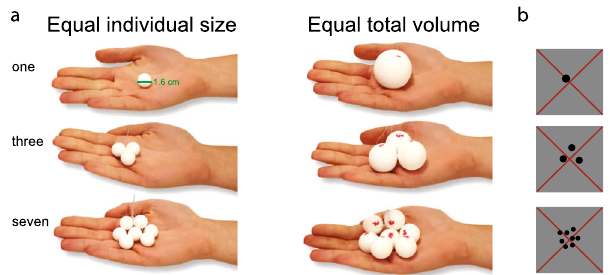
Fig. 1 Illustration of the stimuli. a Static images show the two different haptic stimulus conditions, with examples of different numerosities. In the equal individual size condition, each sphere was the same size irrespective of the number of spheres. So, the total volume of the spheres increased with increasing numerosity. In the equal total volume condition, the total volume of all spheres was kept constant. So, as numerosity increased the individual sphere size decreased. b Examples of the visual stimulus at different numerosities. The total surface area of the dot pattern remained the same across numerosities. A large, thin, red fi xation cross passes diagonally through the center of the display, and through the center of the dot